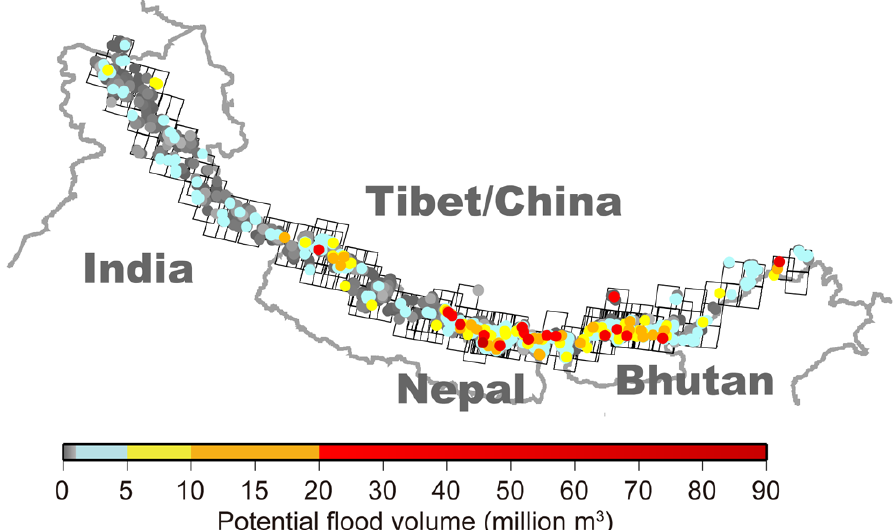
Fig. 7. Potential flood volume (PFV) of 2276 Himalayan glacial lakes. Smaller lakes are obscured by larger ones. Squares denote coverage of ASTER images used in the analysis.